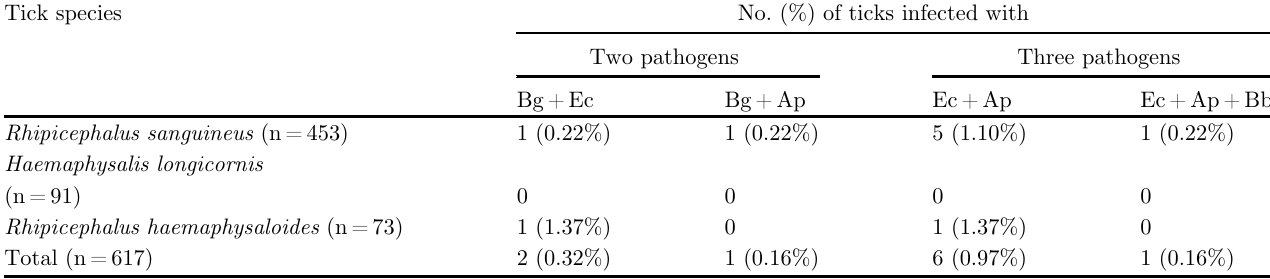
Table 5. Co-infection with pathogens in ticks in this study. Tick